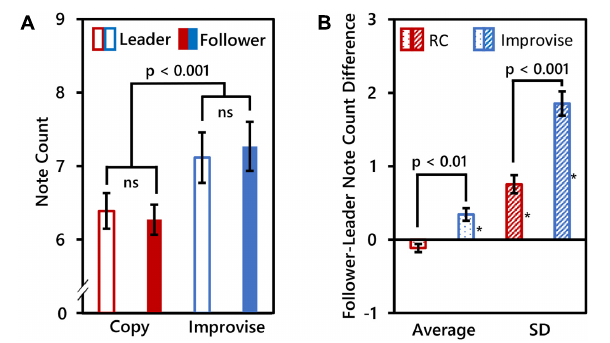
FIGURE 2 | Behavioral comparisons. (A) Mean note counts for Rhythm Copy (RC) and Improvise in the Leader and Follower roles ( N = 17). Results showed that mean note counts in the Improvise conditions were significantly higher than that in the RC conditions, regardless of the roles of Leader and Follower. This indicated an increase in the degree of freedom of the rhythm in the Improvise conditions. (B) Average and standard deviation (SD) of Follower minus Leader note counts across epochs ( N = 14), indicating a significant increase in note count variation between Followers and Leaders in the Improvise condition. Asterisk indicates significant differences from 0 based on single-sample t